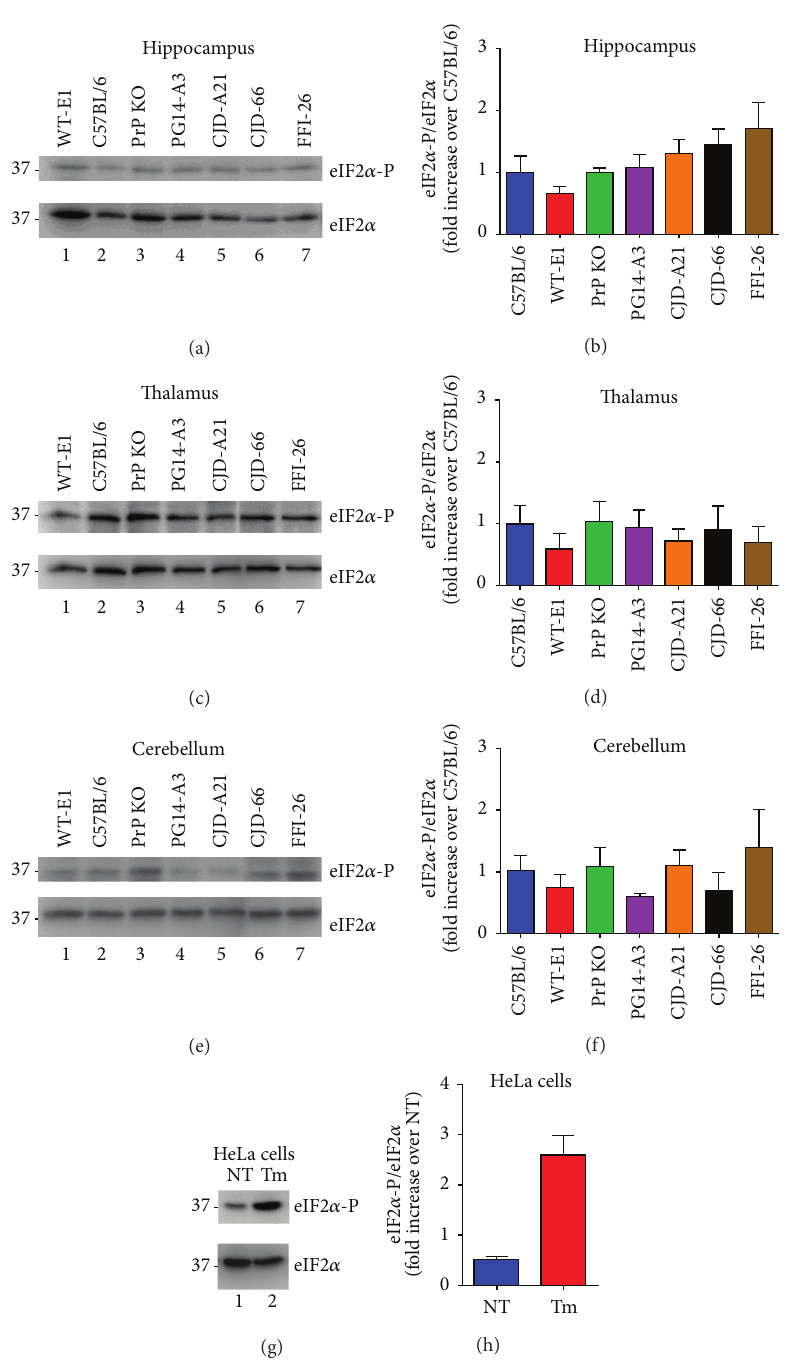
Figure 3: Phosphorylation of eIF2 𝛼 is not increased in brains of mutant PrP mice. The same brain protein extracts (20 𝜇 g) as in Figure 2 ((a)–(f)) or lysates of HeLa cells ((g) and (h)) were analyzed by Western blot with anti-eIF2 𝛼 -P and antitotal eIF2 𝛼 antibodies (1:1000; Cell Signaling). Molecular mass markers are in kilodaltons. Phosphorylation levels were quantified by densitometric analysis of Western blots and expressed as the -fold increase over the level in C57BL/6 mice ((b), (d), (f), and (h)). Tunicamycin (Tm) treated HeLa cells were analyzed at 2 hours as control for UPR activation. Each value is the mean ± SEM of three animals of 300–350 days of age or from three independent cell